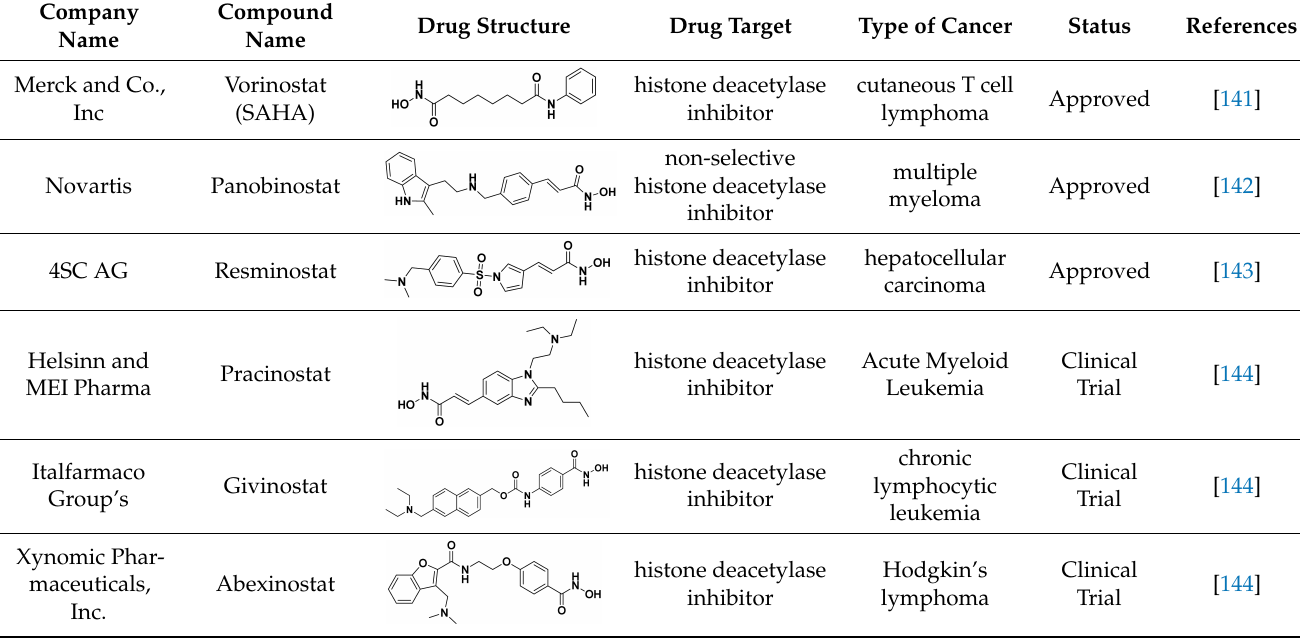
Table 60. Hydroxamic acid-based hybrid compounds approved or under clinical